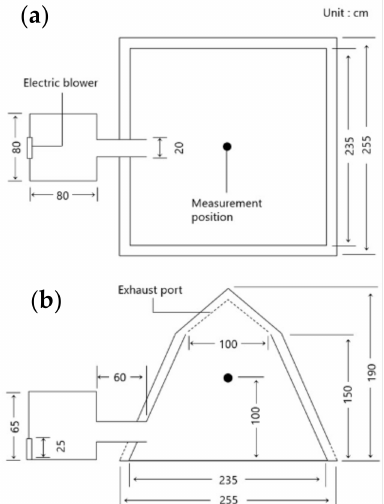
Figure 2. Outline of the saltation experiment. The inlet and the fan installation box are connected to one side of the tent, and the air is blown by the fan. For saltated dust, a particle counter probe is installed on the opposite side of the tent. A sterilized Petri dish that captures dust particles is placed in the center (dot mark point). ( a ) top view, and ( b ) side view shown the mobile dust chamber for the measurement of particle